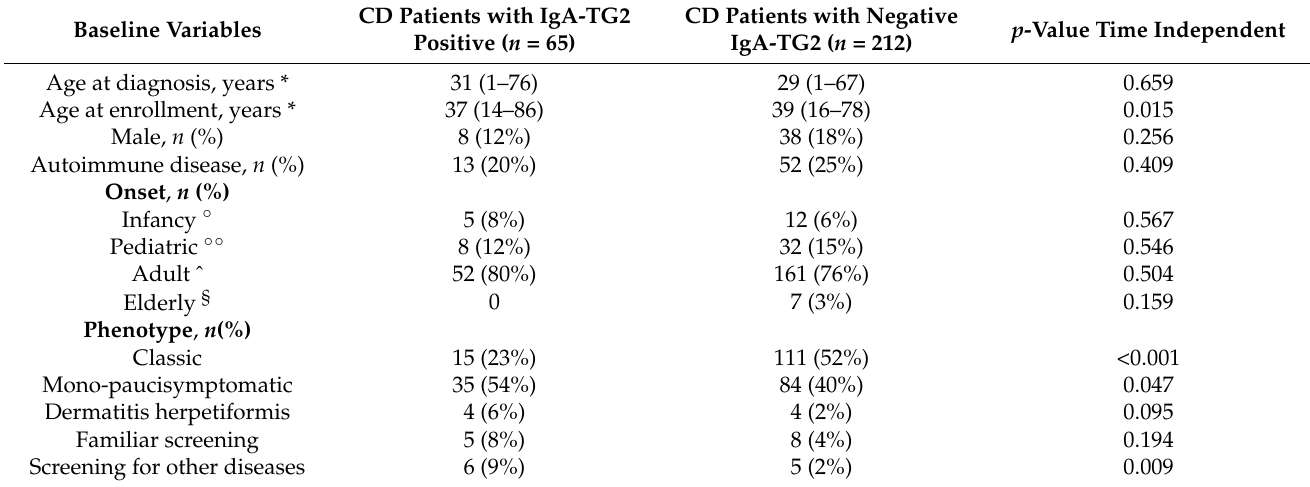
Table 1. Baseline features of CD patients with positive and negative